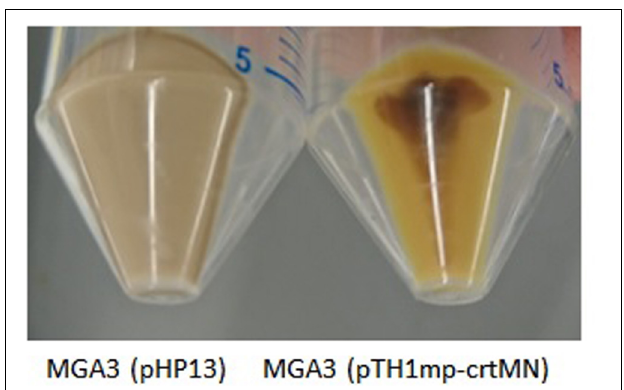
FIGURE 5 | Cell pellets of recombinant B. methanolicus MGA3 (pHP13) and MGA3 (pTH1mp-crtMN) strains cultivated in SWE 50